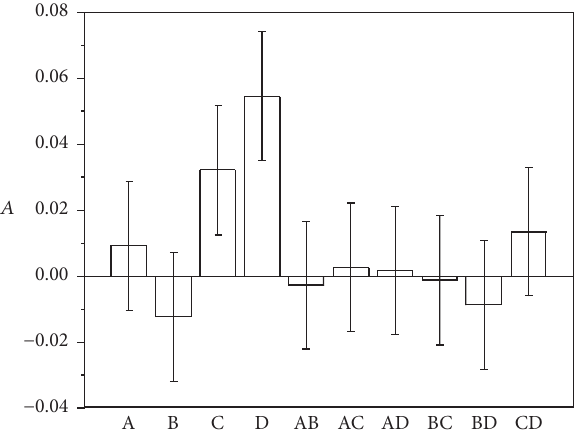
Figure 7: Influence of variables on the AOF-KMnO 4 system for the factorial design (A = KMnO 4 ; B = Na 2 SO 4 ; C = NaOH; and D = T ∘ ).